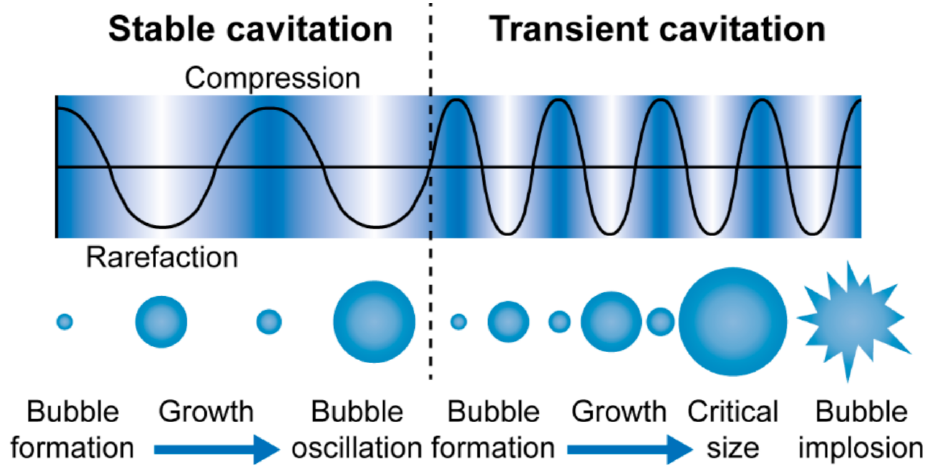
Figure 5. Schematic representation of cavitation bubbles displaying stable and transient cavitation due to continuous compression and rarefaction of the liquid medium under the propagation of an ultrasound wave. Adapted with permission from [126]. Published by The Royal Society of